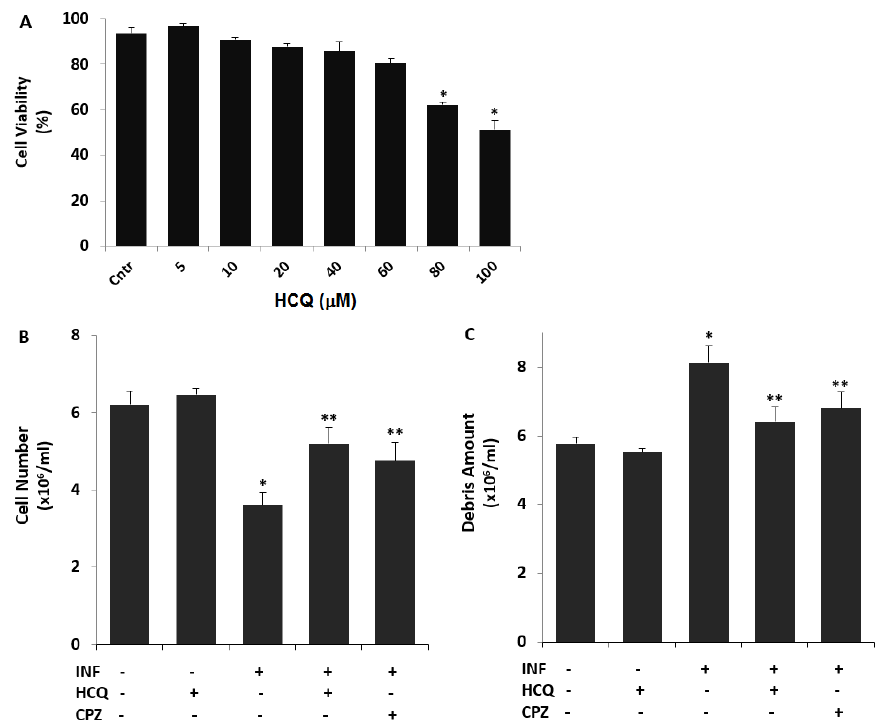
Figure 1. The non-toxic concentration of HCQ the U937 cell line. The effects of HCQ (60 µ M for 48 h) and CPZ (100 µ M for 30 min) on the cell number and debris amount in the U937 cell line treated with LPS (1 µ M for 16 h). The non-toxic concentration of HCQ ( A ), cell number ( B ), and debris amount ( C ) were determined in the cells by using the CASY tone solution of CASY cell counter. (* p < 0.05 vs. Cntr. ** p < 0.05 vs. INF). The significance of p -values was analyzed by using the test of Kruskal–Wallis.